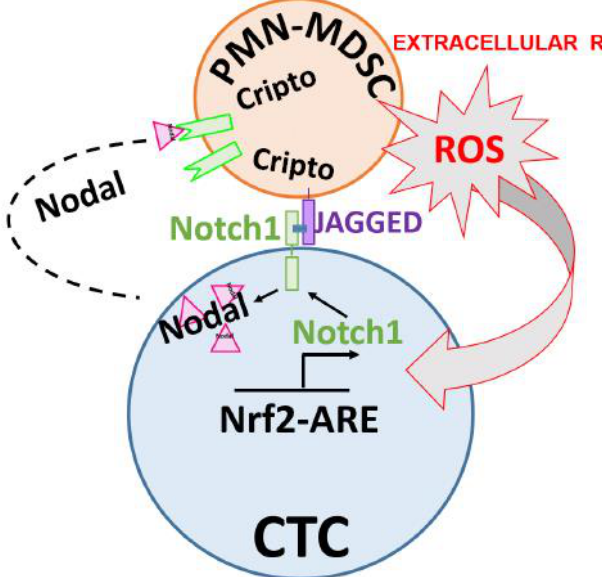
Figure 10. Model outlining biomarkers and pathways between CTCs and PMN-MDSCs interactions (CTC/PMN-MDSC cluster) isolated from blood of metastatic cancer patients. Large red arrow shows PMN-MDSC-secreted ROS affecting CTC-associated Nrf2/Notch1/Nodal pathway. Small black arrows refer to induction of CTC Nrf2-ARE, Notch1 and Nodal gene expression, respectively.